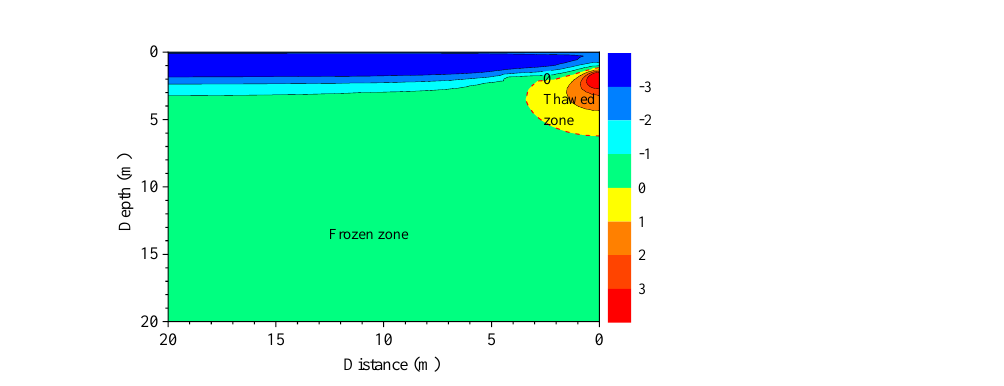
Figure 5. Geo-temperature distributions around the buried pipeline on October 15th at the 0 ( a ),